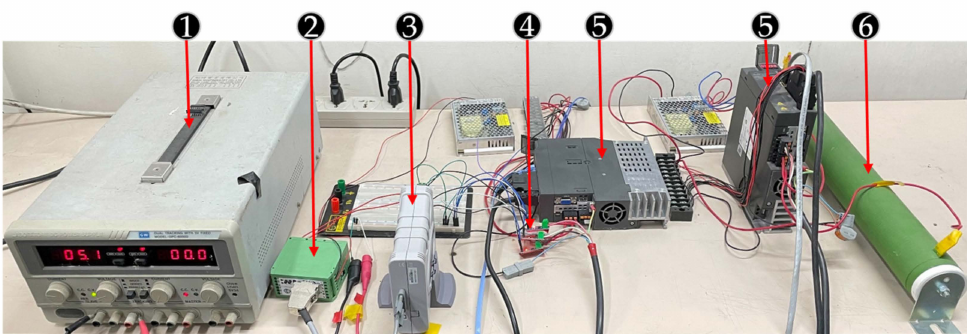
Figure 2. Peripheral devices: (1) power supplier; (2) signal amplifier of speed sensor; (3) USB-2405; (4) hall sensor; (5) actuator; and (6) regenerative